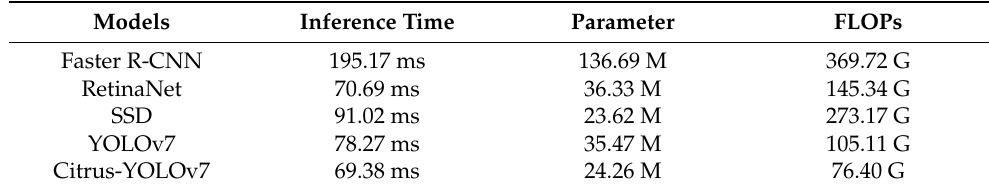
Table 3. Comparison of prediction speed and computing resources.